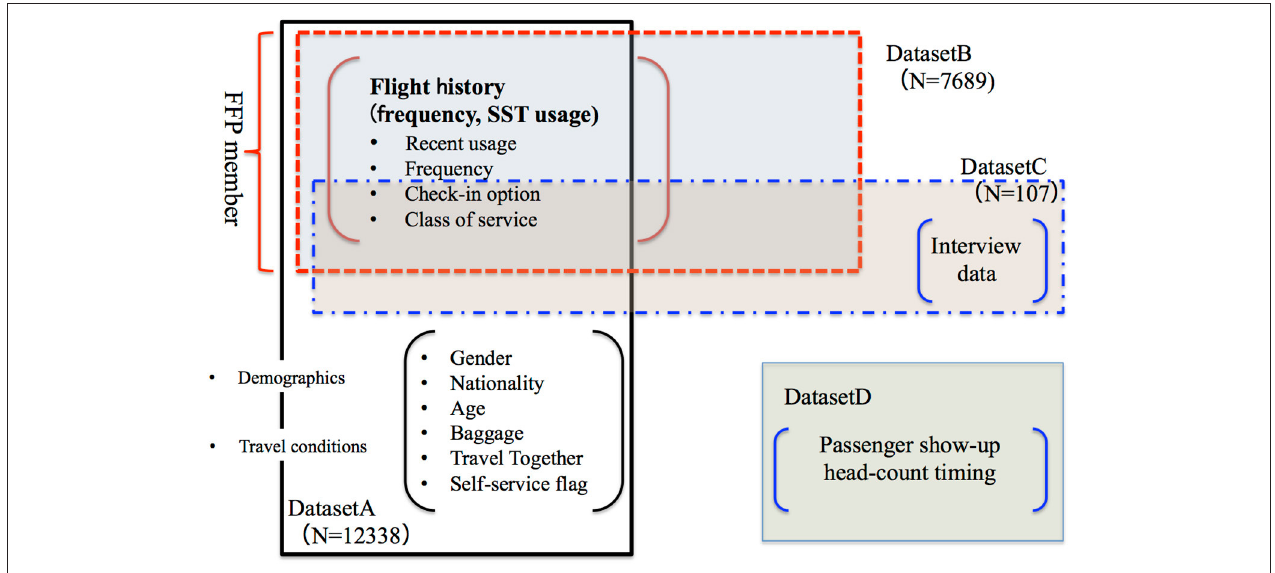
FIGURE 4 | Dataset for experiments.